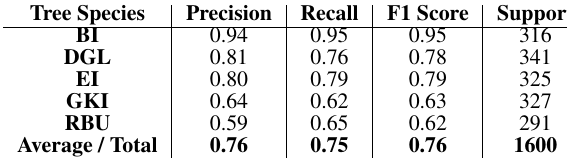
Table 3. Precision, recall, F1 score and support for CNN classification with image